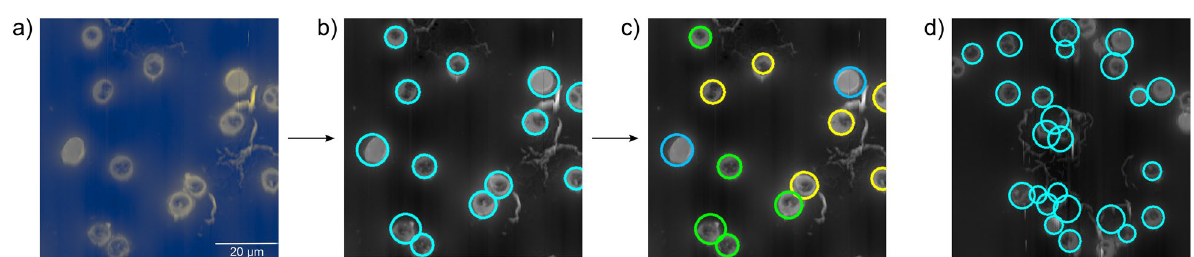
Figure 3. Illustration of the extraction process of single-RBC images from AFM topography pictures. ( a ) Raw topography image. ( b ) Cell identification: individual RBCs are detected by the Hough gradient method and marked by cyan circles. ( c ) Manual classification: the cells are labelled by experts as healthy (lightblue), infected by ring-stage (blue), trophozoite-stage (yellow) and schizont-stage (green) parasites. (RBCs infected by rings are not present in the sample image.) Cell extraction: The detected cells are extracted from the raw image and saved with the respective label. ( d ) Sample image of undetected RBCs and false